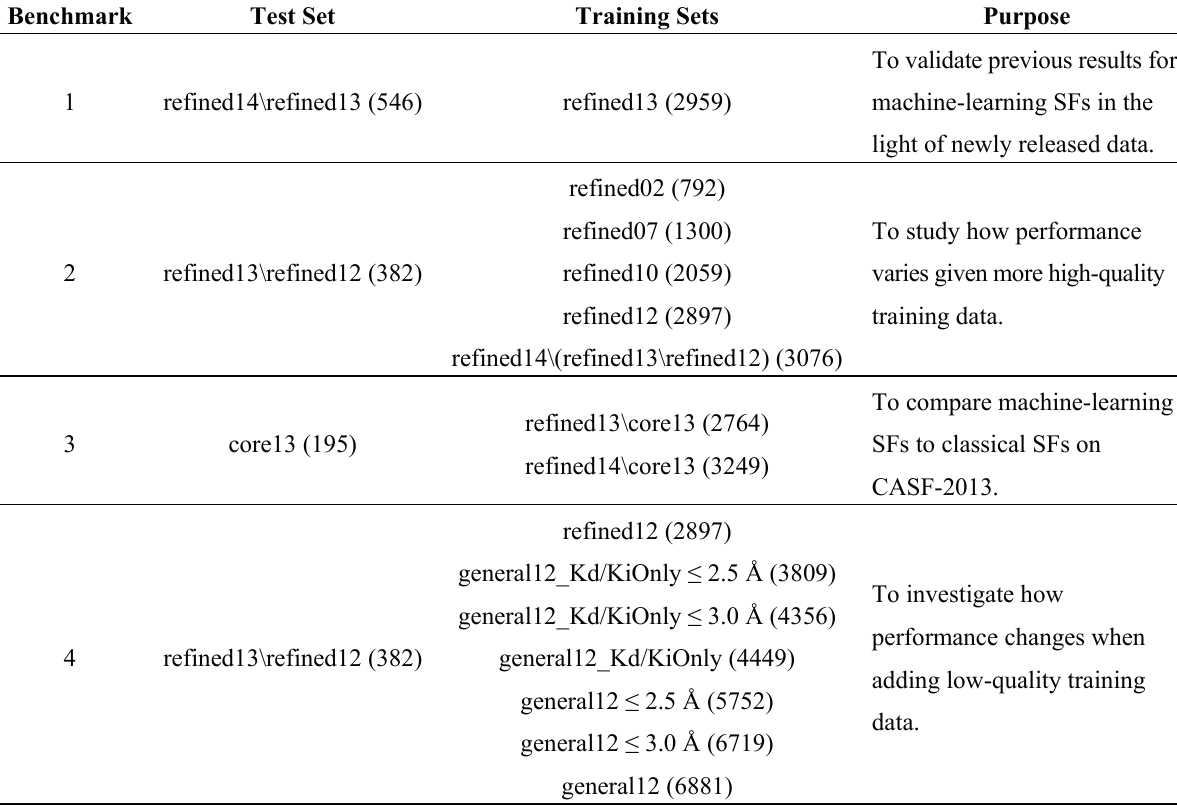
Table 1. Summary of the four benchmarks (number of complexes between brackets).